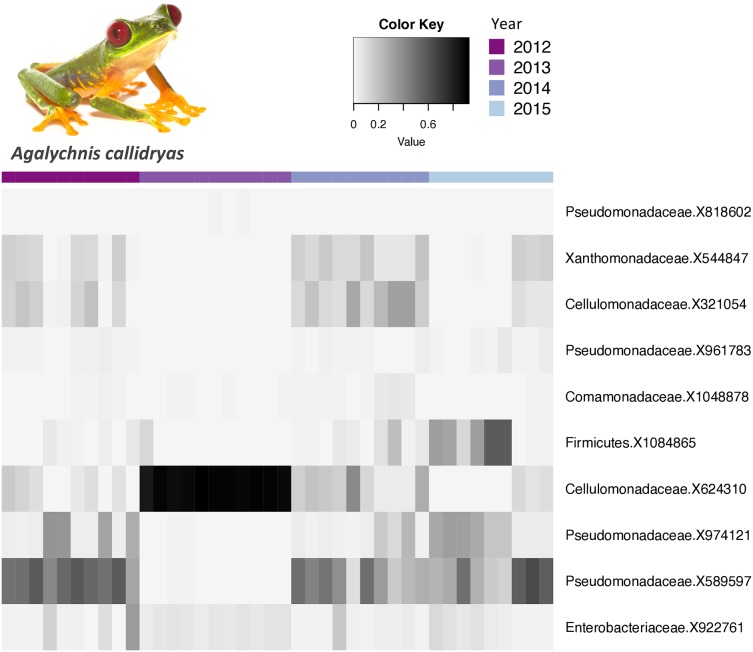
Relative abundance of core bacterial taxa on Agalychnis callidryas across years.Relative abundance of Agalychnis callidryas core bacterial taxa (OTUs found on 100% of the frogs) across years. Darker shades indicate higher relative abundances and lighter shades indicate lower relative abundances. Photo credit: Brian Gratwicke.